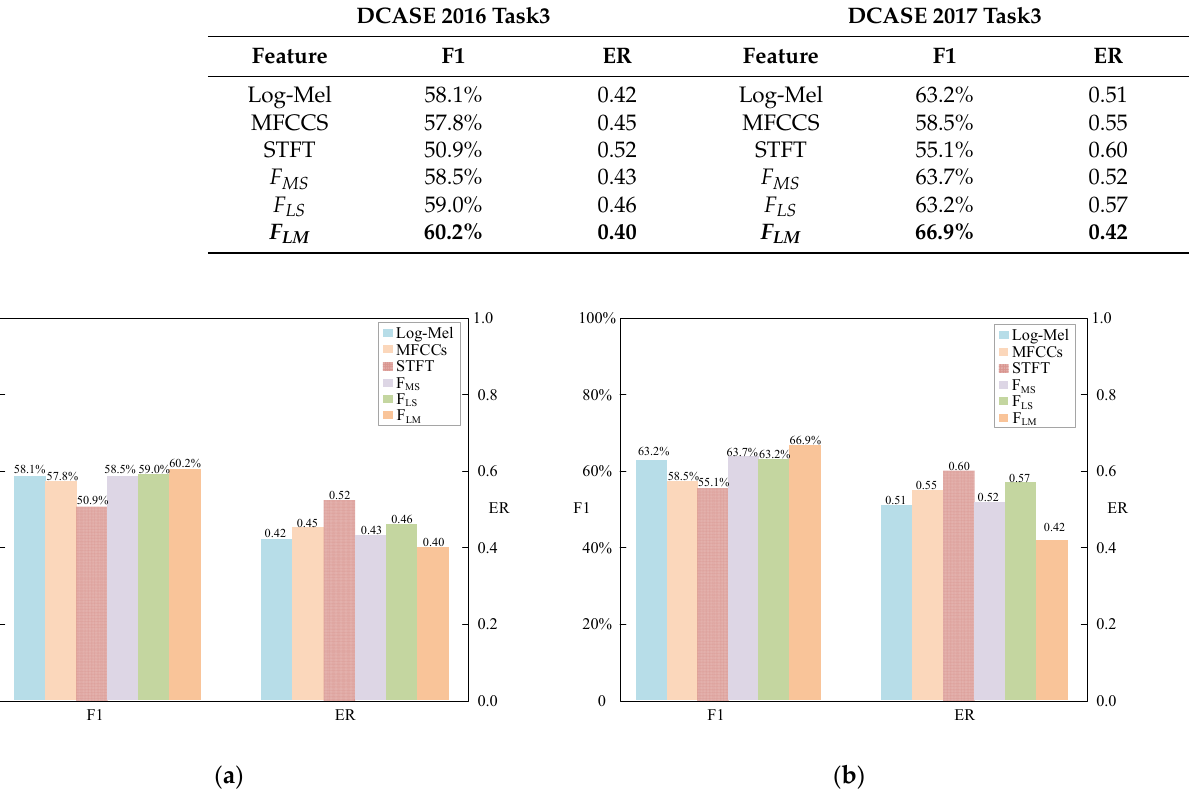
Table 3. The results of different features on TFFS-CRNN.